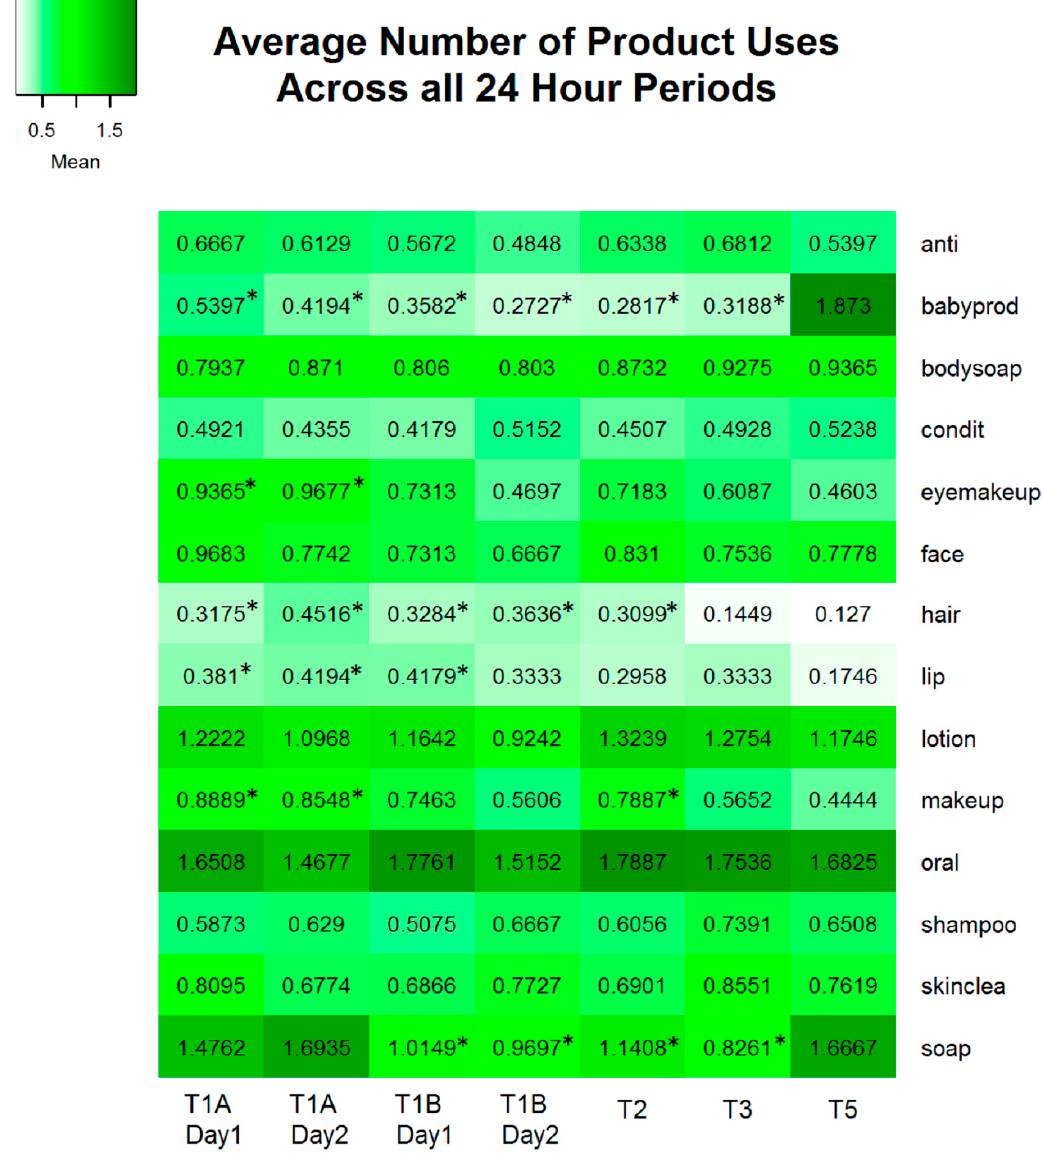
Figure 7. The average number of product uses in each 24 h period. Results that are significantly different from the postpartum (T5) reference period ( p ≤ 0.05) are indicated with an *.